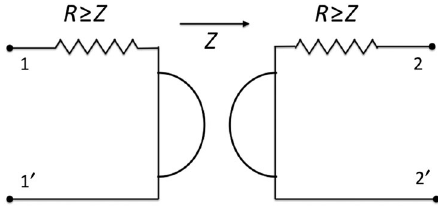
FIG. 6. A circuit representation of the response that is achiev- able using the Ohmically contacted Hall bar of Fig. 5. The lossy (diagonal) part of the impedance matrix R fundamentally cannot be smaller than the antisymmetric lossless gyration resistance Z